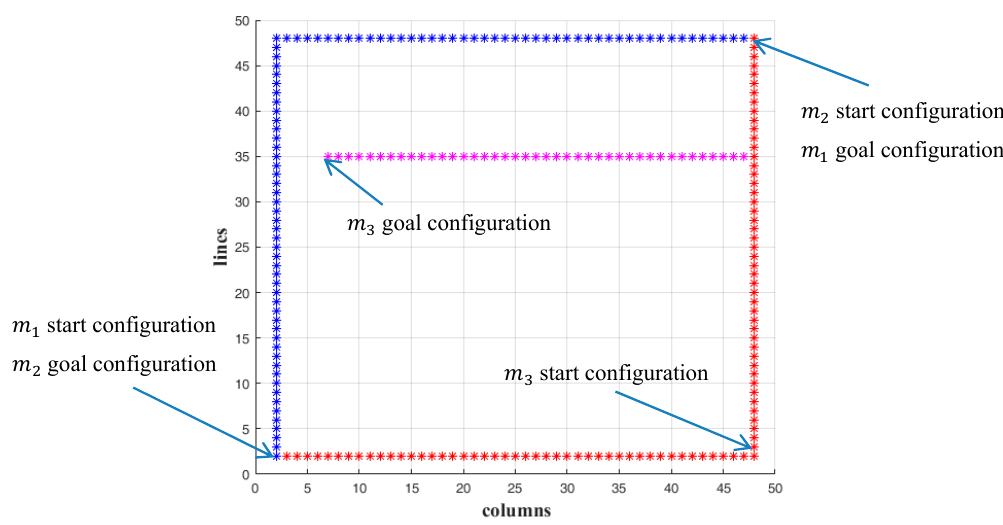
Figure 24. The 2D representation of the path computation of the three microparts with the computations of Equation (12).